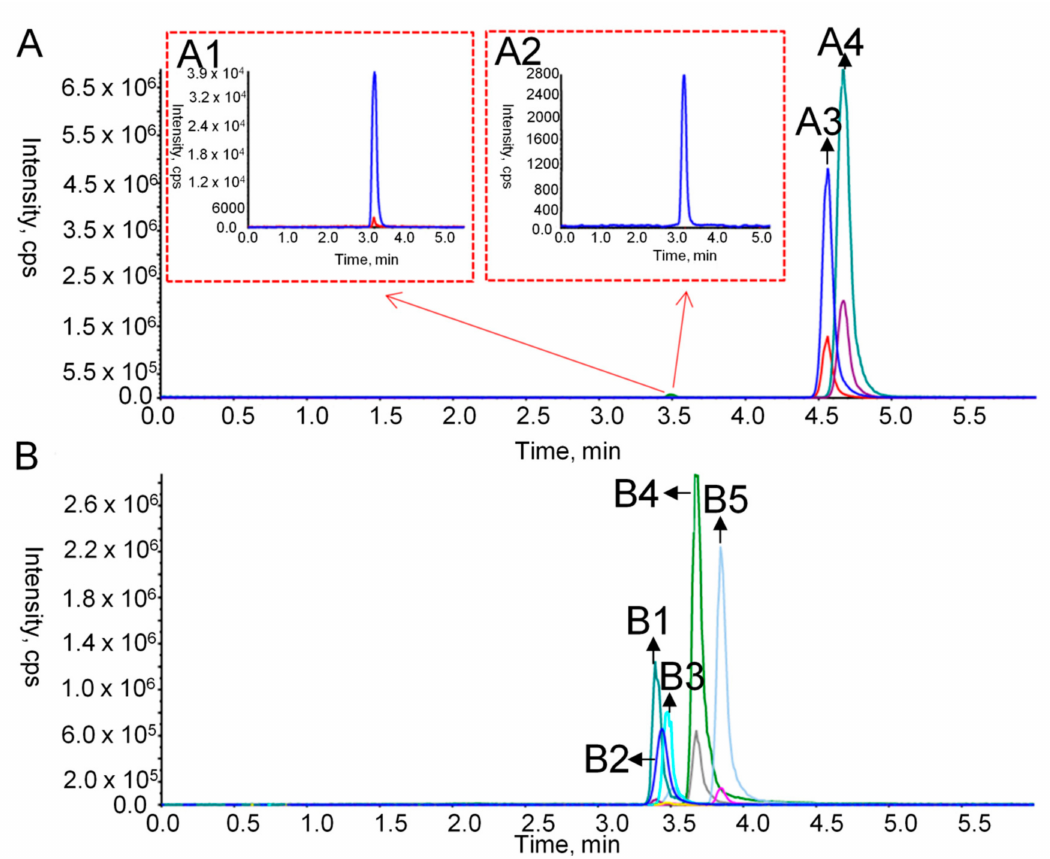
Figure 6. TIC diagrams of nine flavonoid standards in the positive and negative ion mode. ( A ) the positive ion mode; A1 represents the chromatograms of narcissin (retention time = 3.51 min); A2 is the ones of isorhamnetin-3-O-beta- d -glucoside (retention time = 3.53 min); A3 is the ones of nobiletin (retention time = 4.56 min); A4 is the ones of tangeretin (retention time = 4.67 min); ( B ) the negative ion mode; B1 represents the chromatograms of quercetin-7-O-glucoside (retention time = 3.43 min); B2 is the ones of rutin (retention time = 3.44 min); B3 is the ones of kaempferol-3-O-glucoside (retention time = 3.50 min); B4 is the ones of quercetin (retention time = 3.69 min); B5 is the ones of isorhamnetin (retention time = 3.84